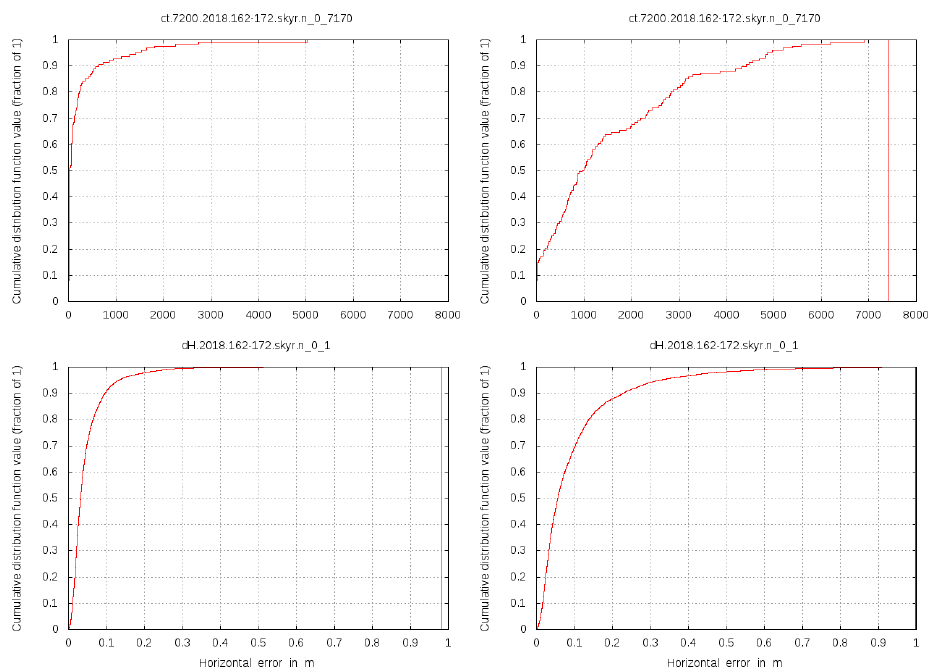
Figure 7. Summary of results for roving user SKYR. First row: Percentage of cumulative cases, over the 132 roving user resets between days 162 to 172, 2018, vs. convergence time for horizontal positioning error, in seconds. Second row: Corresponding final horizontal positioning error, in meters. First column: WARTK, constraining ambiguities updating them at every chance, and slightly estimating the permanent receivers coordinates; second column: no ambiguity constraining (i.e., without using the WARTK ionospheric